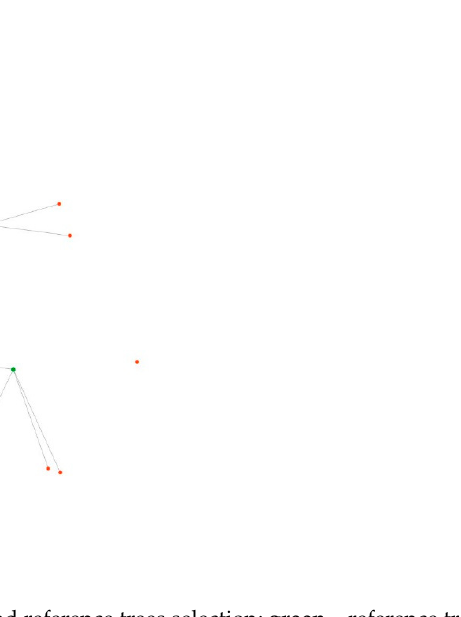
Figure 5. Nearest neighbors identification and reference trees selection; green —reference tree; red — marginal tree. Table 3. Horizontal structure indices in the 15 m-radius subplot.